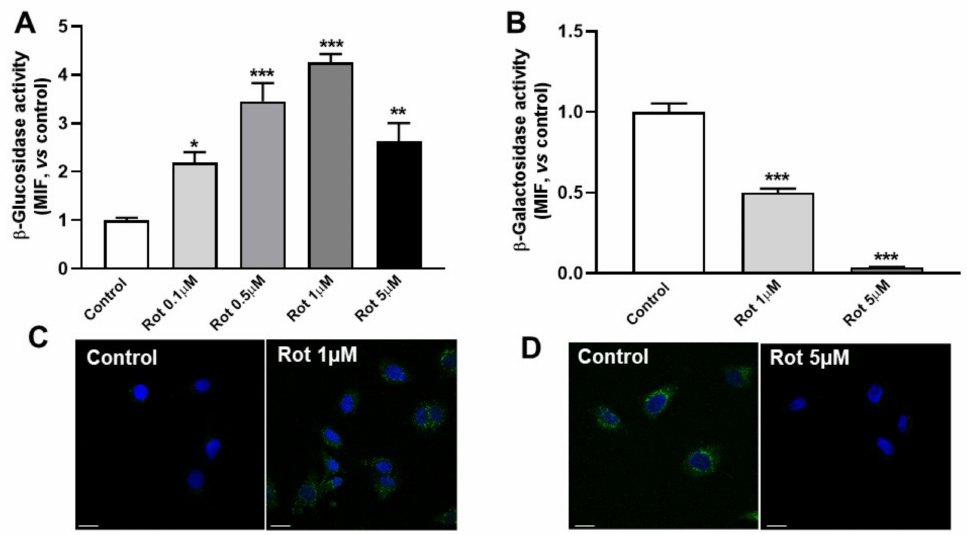
Figure 3. Rottlerin alters β -galactosidase and β -glucosidase activities. C6 cells were incubated in LPDS medium for 2 h, then treated with or without (Control) rottlerin (Rot), then the reaction substrates for β -galactosidase (C12FDG) or β -glucosidase (FDGlu) were added for the last 30 min and analyzed by flow cytometry or immunocytochemistry. ( A ) The β -glucosidase activity analyzed by flow cytometry. ( B ) The β -galactosidase activity analyzed by flow cytometry. The control is normalized to 1. Results are the mean ± SEM of three independent experiments. MIF, median intensity of fluorescence. Statistical comparisons shown are treatment versus control (* p < 0.05, ** p < 0.01, *** p < 0.001). ( C ) Immunocytochemistry of β -glucosidase after treatment with or without rottlerin. ( D ) Immunocytochemistry of β -galactosidase activity after treatment with or without rottlerin. Images show the reaction product in green, and the nuclei labeled with Hoechst-33342 in blue. Representative results from three independent experiments are shown. Scale bars = 25 µ